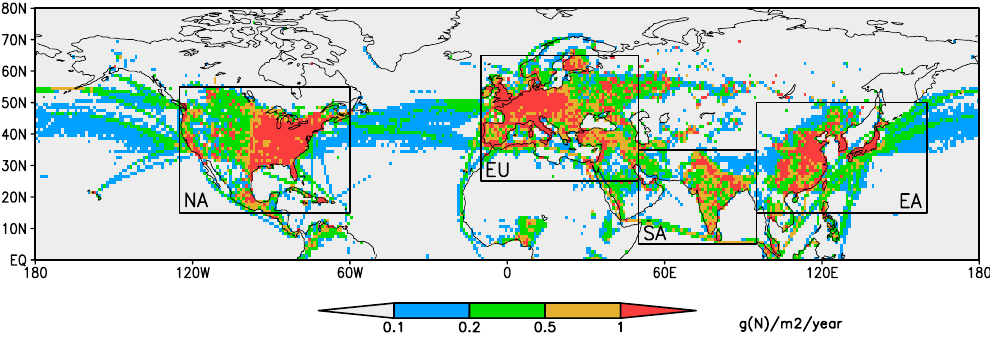
Fig. 1. Anthropogenic surface NO x emissions (gNm − 2 yr − 1 ) for year 2000 from Lamarque et al. (2010) showing the HTAP source-receptor regions considered here: N. America, Europe, S. Asia and E.